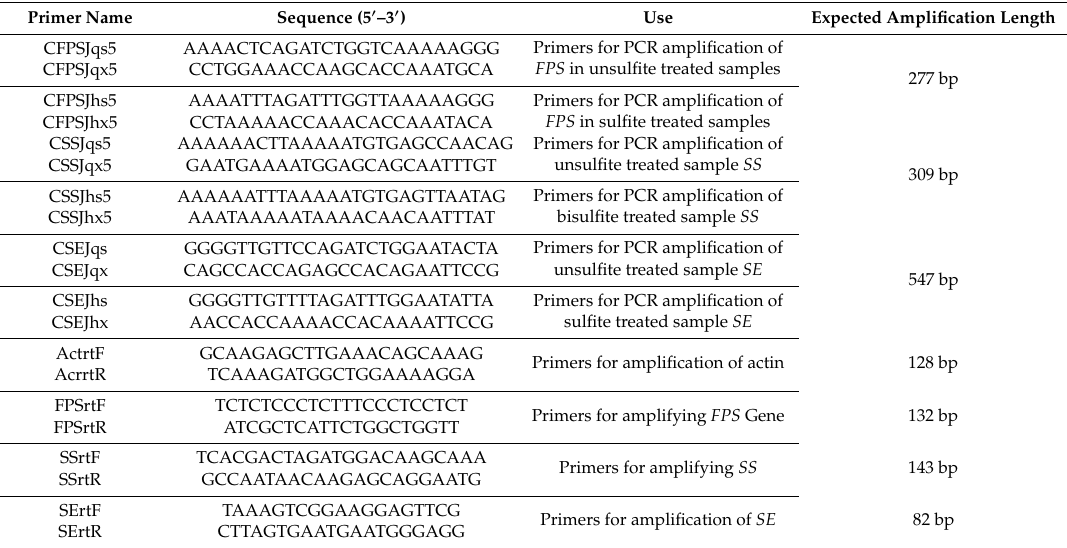
Table 1. DNA methylation site analysis and real-time fluorescence quantitative PCR primers of the farnesyl diphosphate ( FPS ), squalene synthase ( SS ), and squalene epoxidase ( SE ) promoters of Eleutherococcus